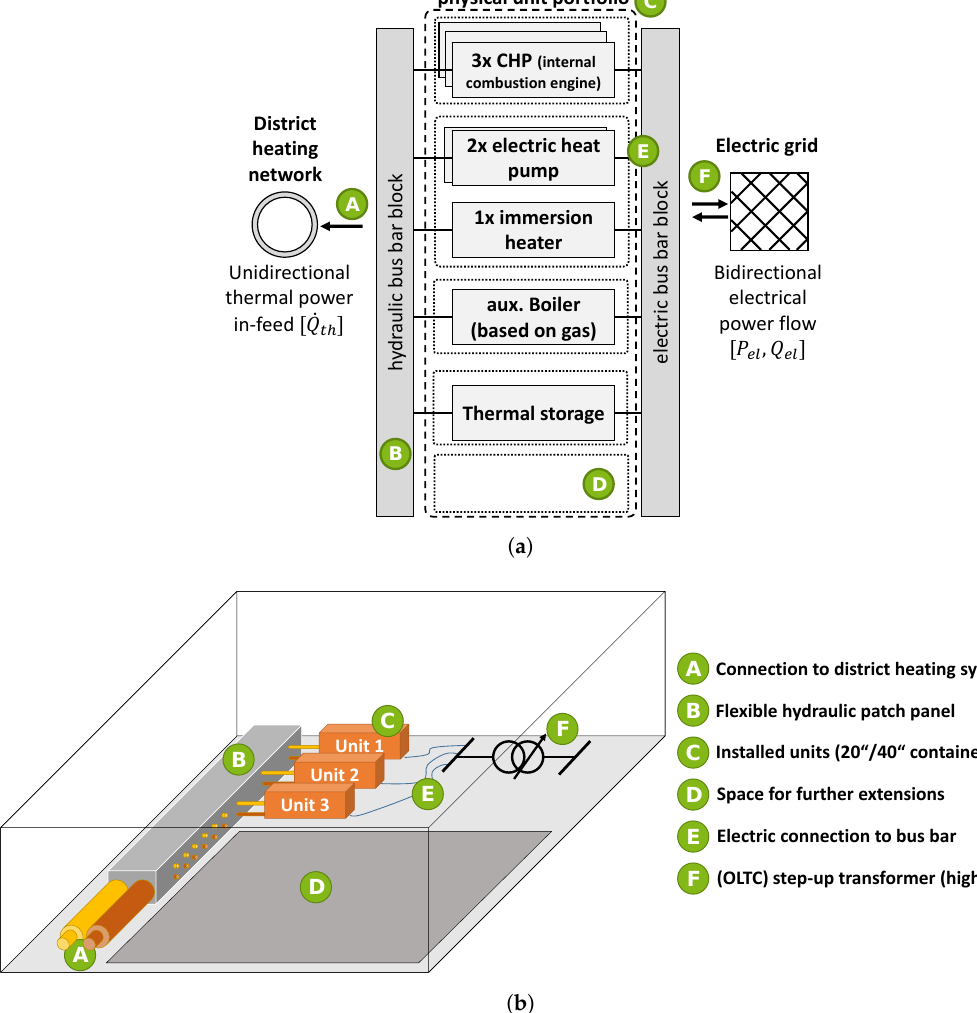
Figure 3. Overview of system architecture with thinkable, fully optional modules (none mandatory, all to be implemented at will and at any time). ( a ) Exemplary specific configuration of a unit portfolio with different technologies being modularly integrated; ( b ) Floor layout indicating one practical implementation of the system architecture (not to